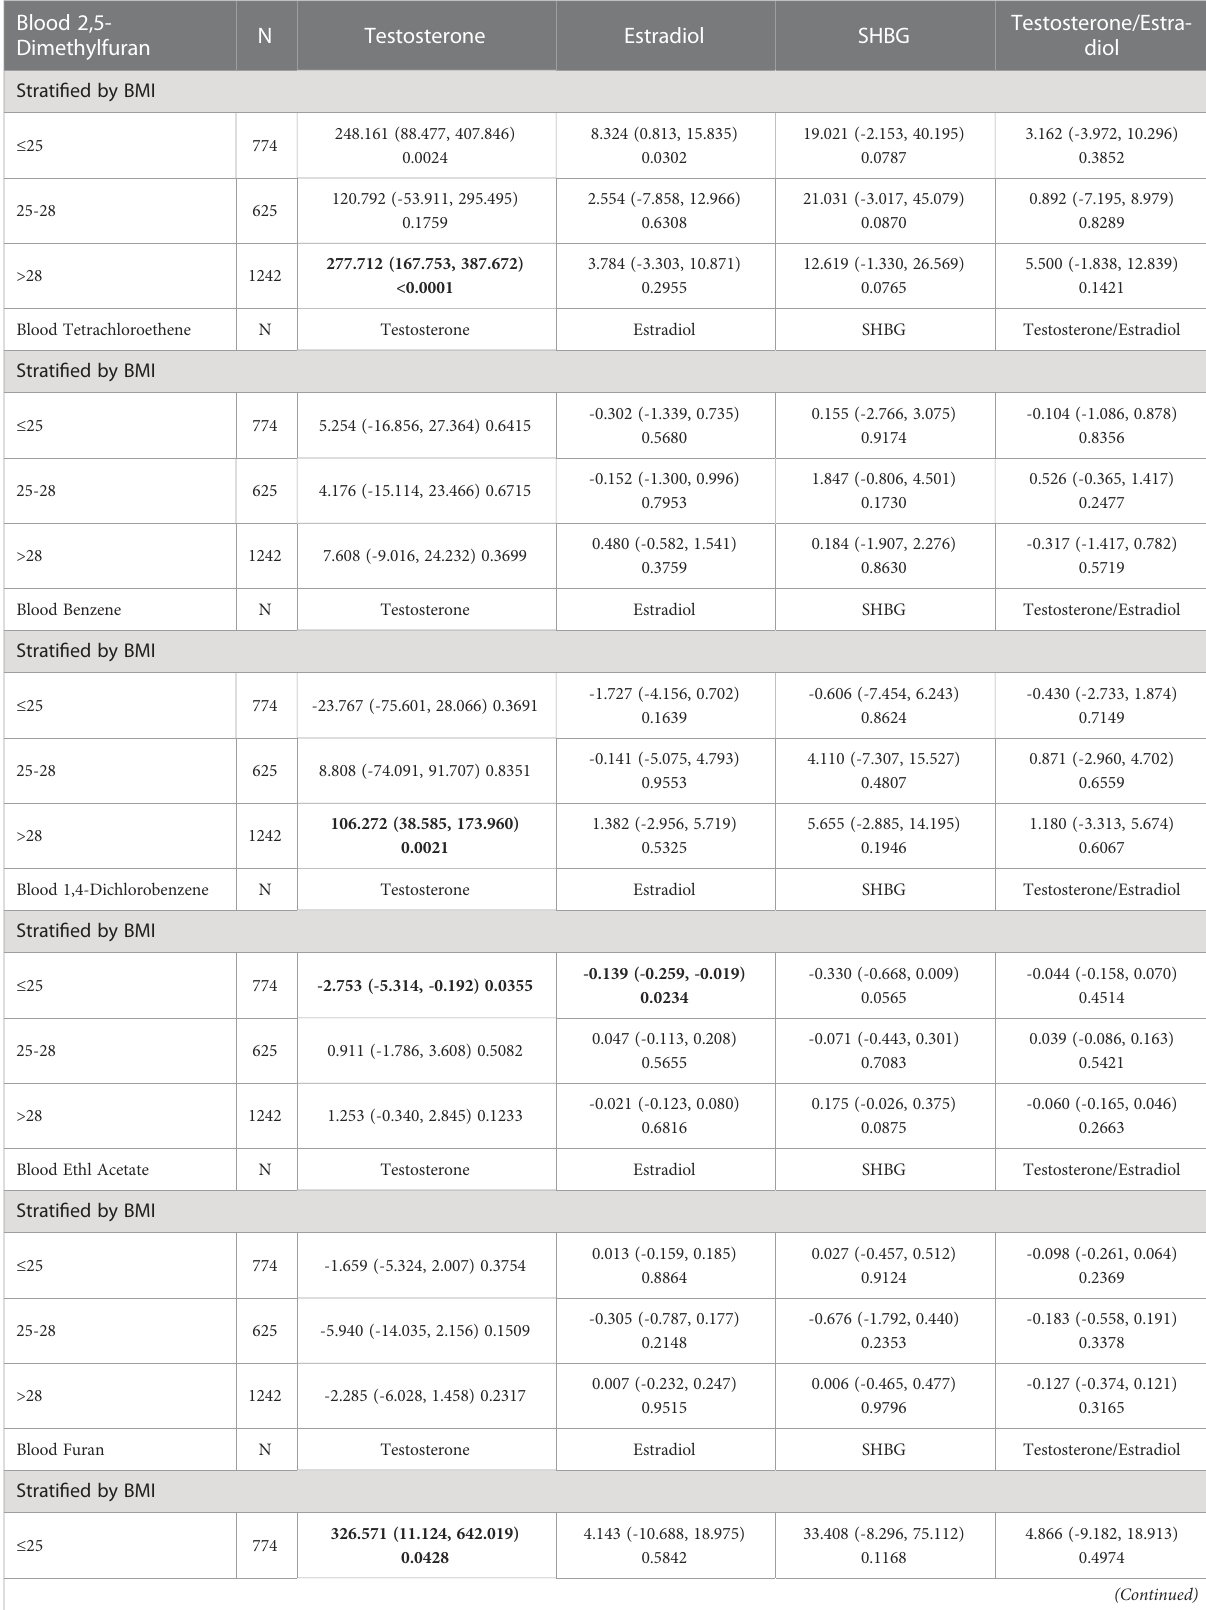
TABLE 2 Strati fi ed associations of blood VOCs on sex hormones in the prespeci fi ed and exploratory subgroup. Blood